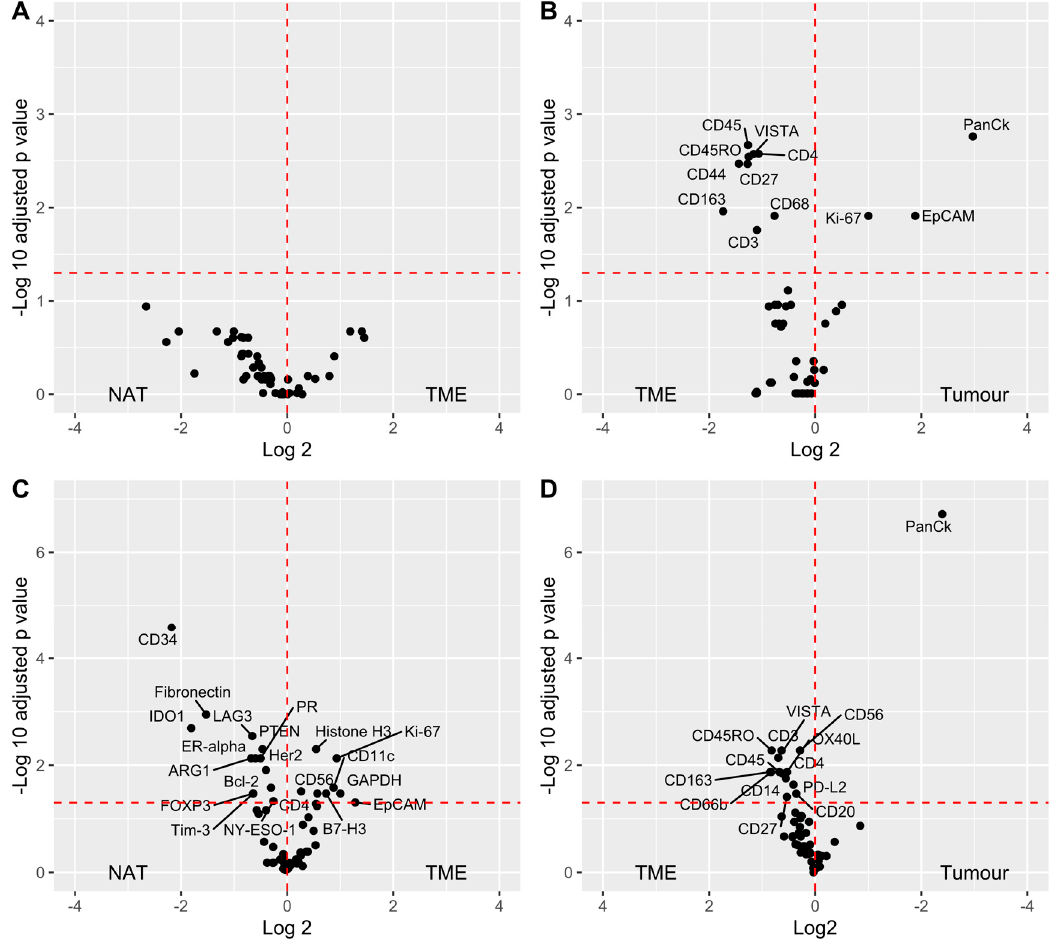
Figure 7. Differential expression of proteins between tissue compartments. Paired t -tests with a Benjamini–Hochberg correction were performed between matched compartments. Mann–Whitney tests with Benjamini–Hochberg correction were performed between unmatched compartments; p- values adjusted for multiple testing were used to identify significantly differentially expressed proteins. ( A )